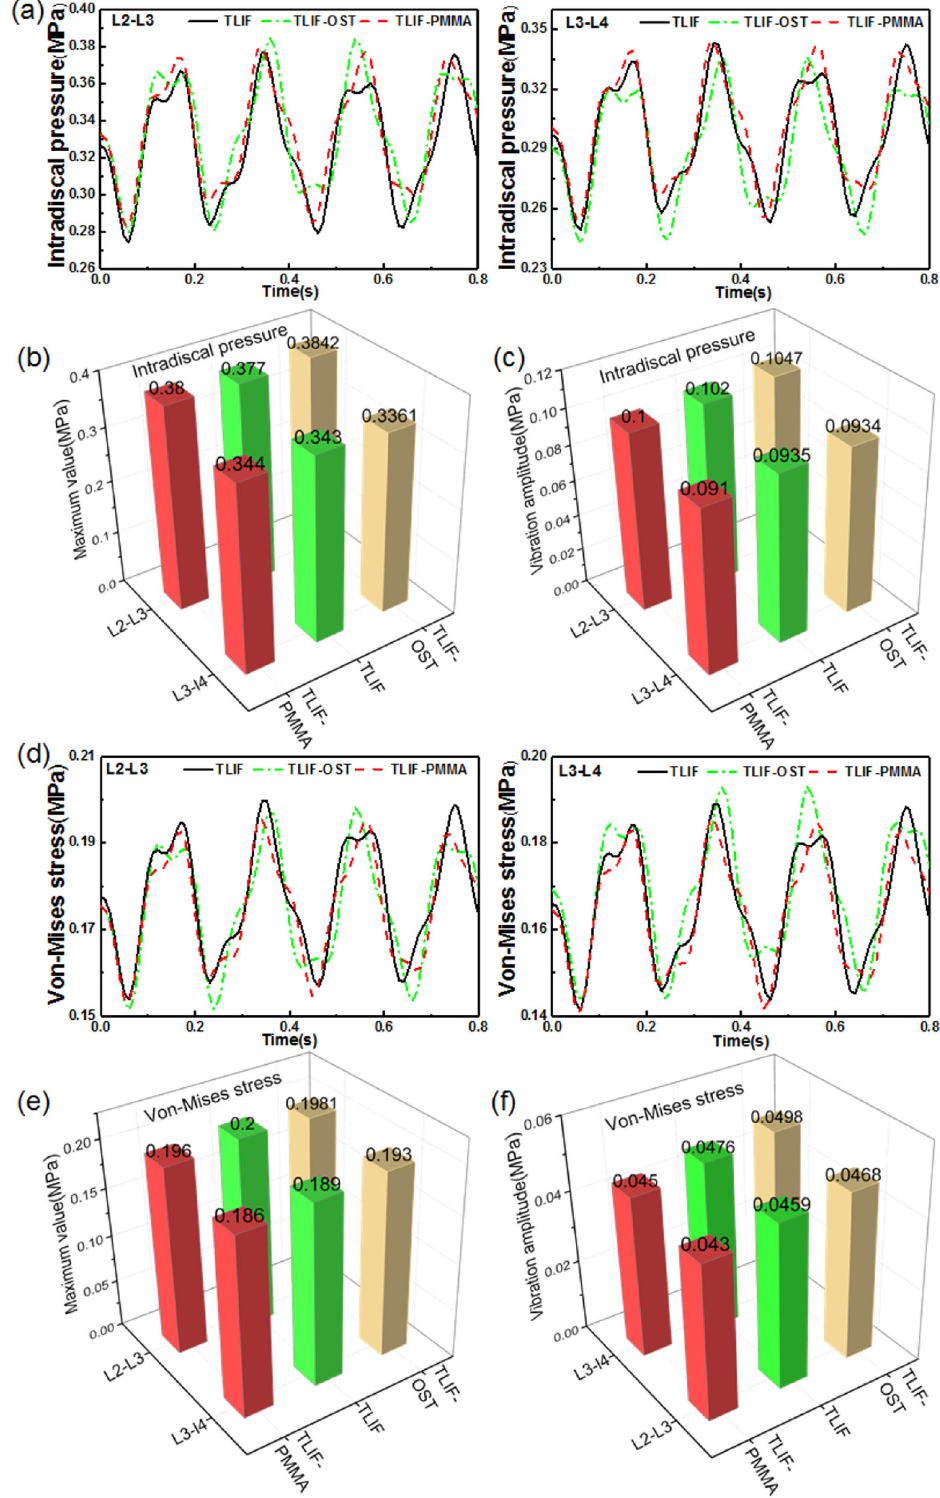
Fig. 4 The dynamic response at the adjacent segments (L2-L3 and L3- L4 levels) for fusion models. a IDP, b the maximum values of IDP, c vibration amplitudes of IDP, d Von-Mises stress in the AGS, e the